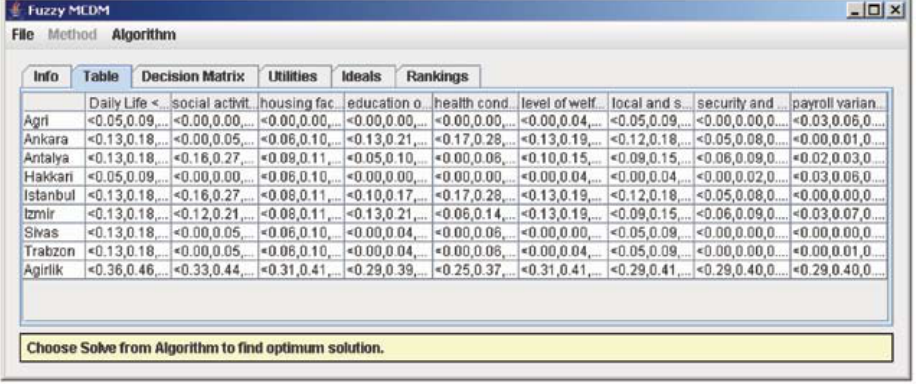
Fig. 4. Ideal-based method applied to the military staff assignment problem